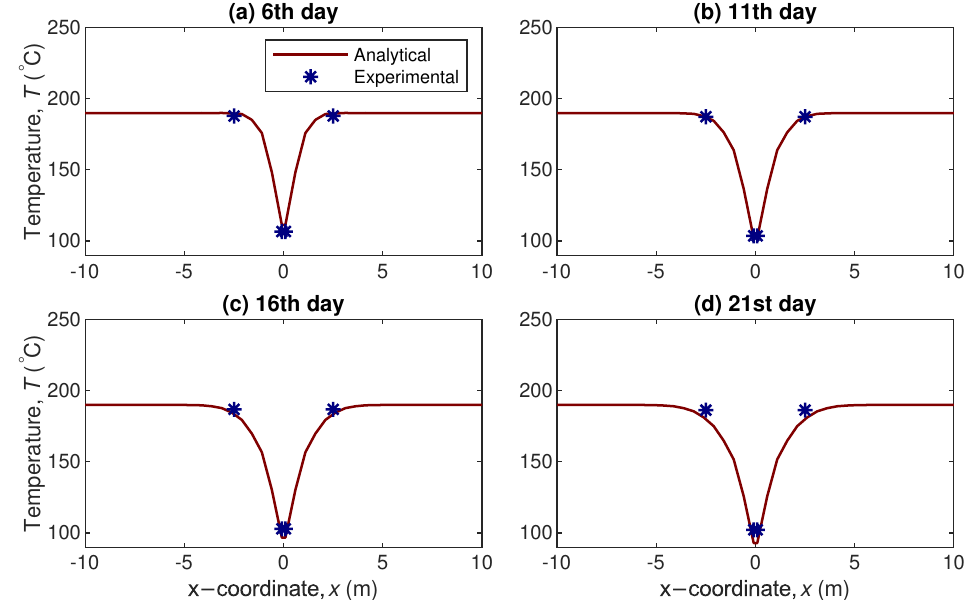
Figure 9. Comparisons between the analytical model and the field-scale experimental data from [40] regarding the temperature profile at a depth of 400